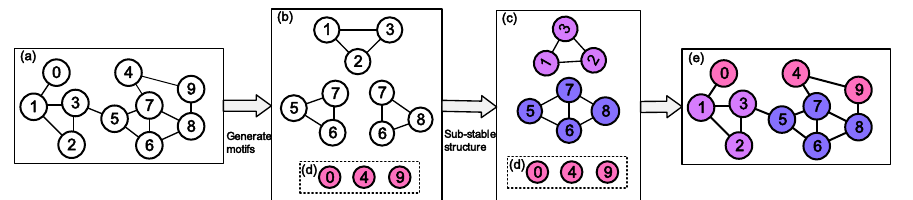
Figure 3. The elite structure phase. ( a ) A graph structure of the network. ( b ) Generate motifs according to defition 1. ( c ) Calculate sub-stable structure by defition 2. ( d ) Nodes that have not yet been aggregated. ( e ) Preliminary division of the network.